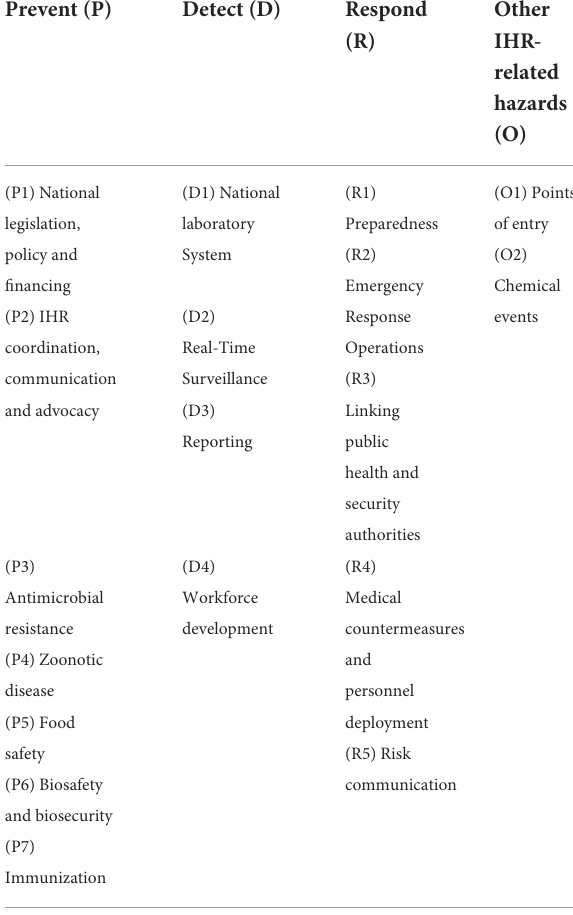
TABLE 3 Categories of assessment under key elements in joint external evaluation tool a , sustainable development goals, one health, India,